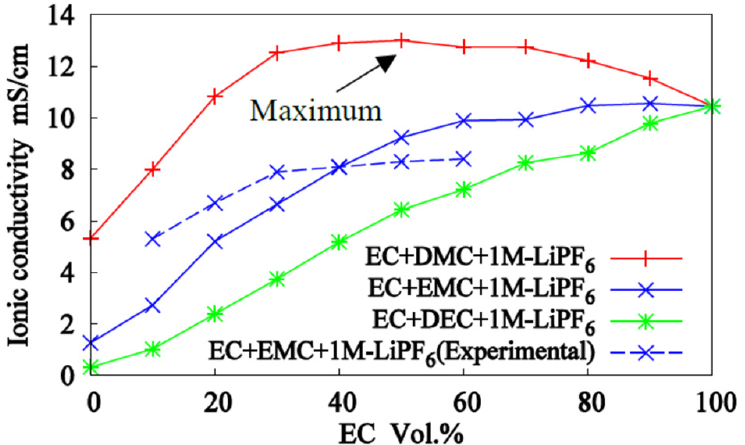
Figure 9. Ionic conductivity in mixed-electrolyte models.